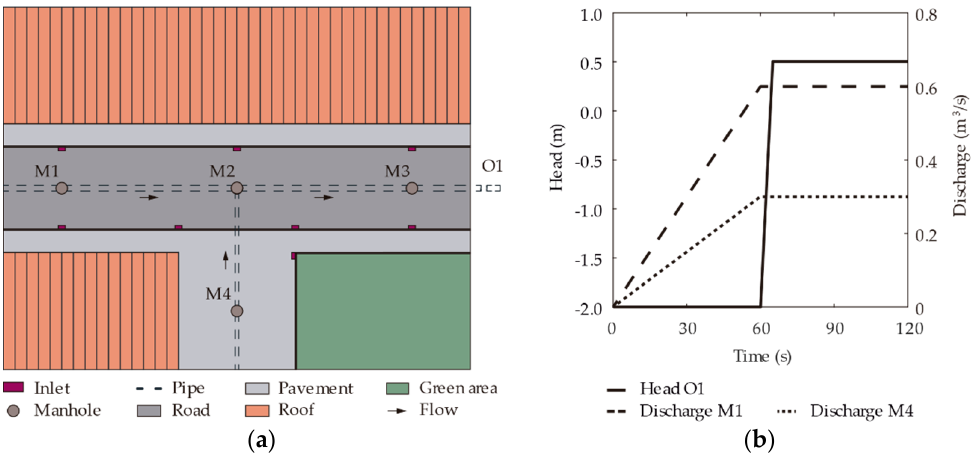
Figure 2. ( a ) Scheme of the urban street; ( b ) boundary conditions at manholes and outfall.